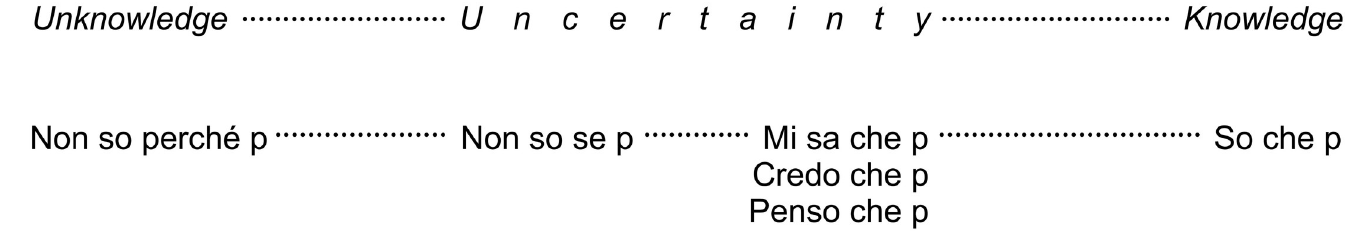
Fig 1. The six sentences along the epistemic